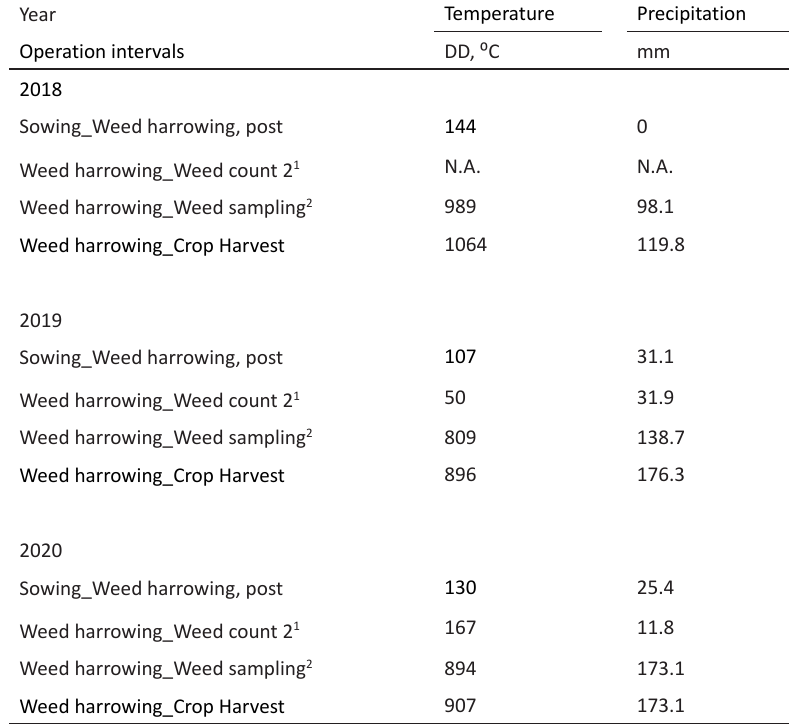
Table 1. Accumulation of effective temperature sum (ETS, Day Degrees, base +5 o